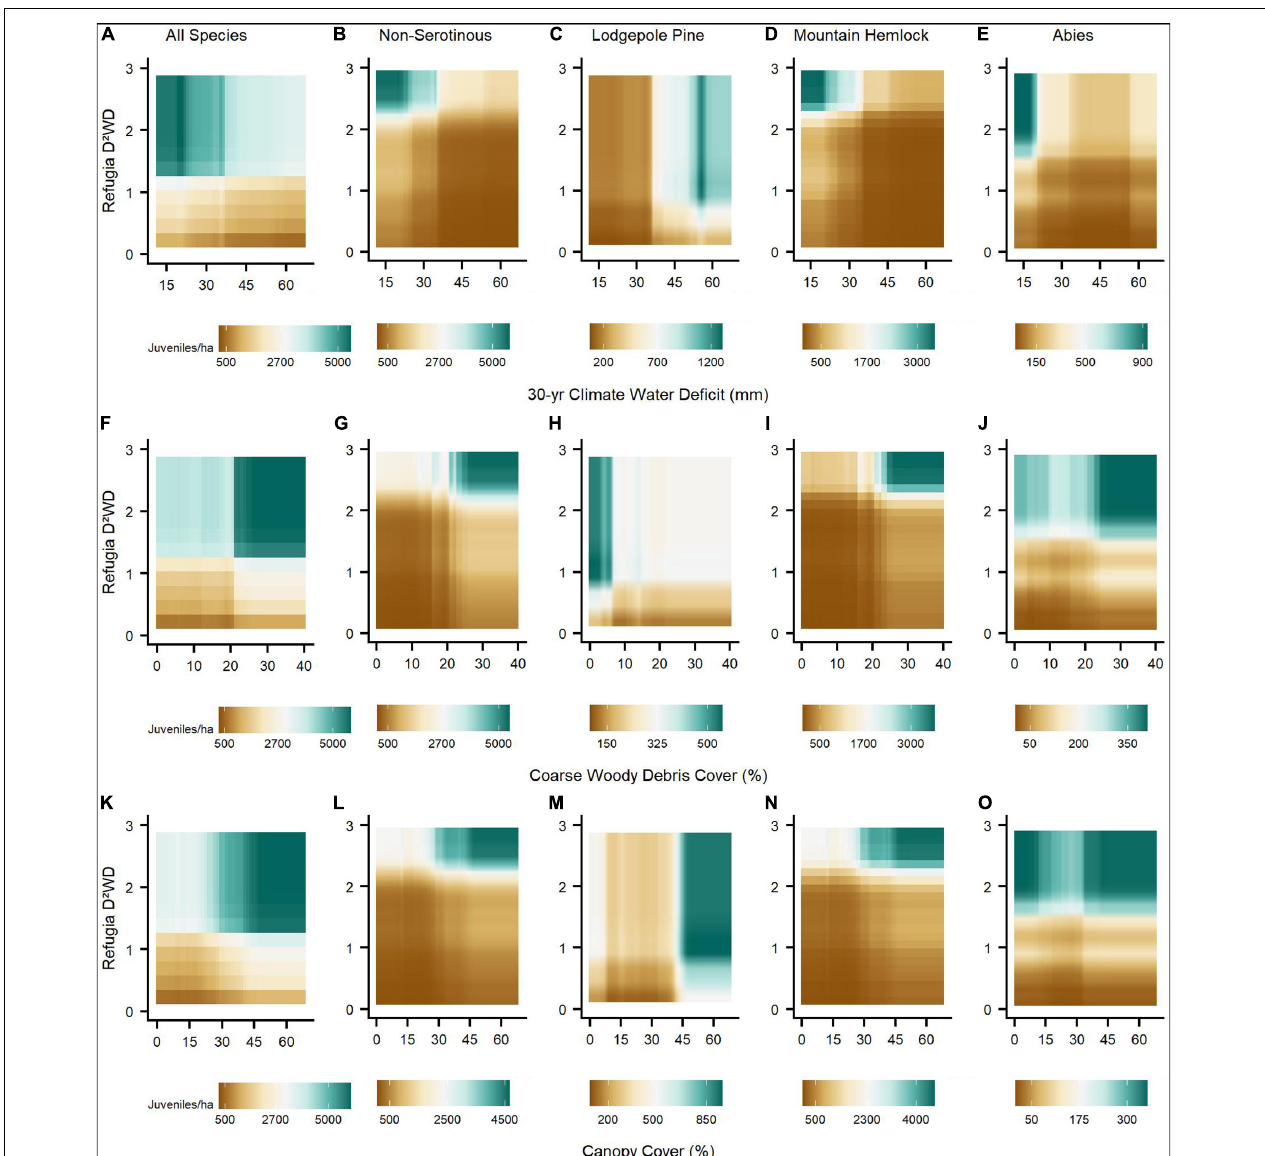
FIGURE 5 | The strongest pair-wise interactions between refugia, climate, and environmental variables across species assemblage BRT models. Post-fire seed availability (refugia D2WD) interacted strongly with (1) 30-yr climate water deficit (mm; A–E ), (2) coarse woody debris cover (%; F–J ), and (3) canopy cover (%; K–O ). Along the brown-to-blue-green color spectrum, brown shading indicates relatively reduced and blue-green shading relatively increased post-fire establishment due to pair-wise variable interactions. Refugia D2WD values ranged up to 10, but interaction responses did not change above a refugia D2WD value threshold of 3 across species